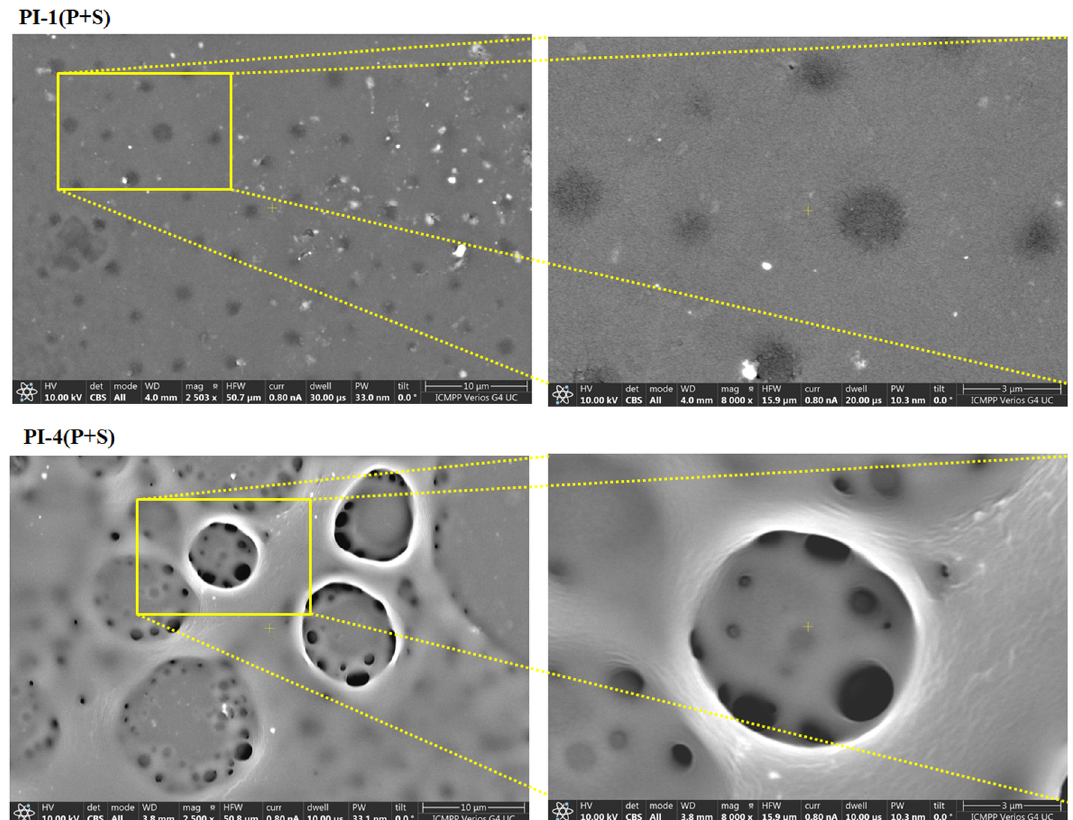
Figure 7. The SEM images of the plasma-treated and -sprayed PI-1(P+S) and PI-4(P+S) films. The AFM images and corresponding average cross-section profiles collected for the investigated PI-1 and PI-4 samples before and after DCSBD plasma treatment (P) and DCSBD plasma treatment, followed by spraying (P+S), are presented in Figures 8 and 9, respectively. The starting samples had surfaces with low values of roughness, 2–5 nm, as seen in Table 2. According to the height distribution on the Z axis placed on the right side of the AFM image, PI-1 showed relief with predominantly low formations, while the relief of PI-4 was mostly made up of globular formations densely and uniformly arranged on the entire surface. For this reason, the complexity of the surface morphology, expressed by calculating the surface area ratio parameter (Table 2), was higher for the copolymer. For the unmodified PI films, it can be noted that the root mean square roughness (Sq) was similar to other PI structures containing alicyclic units and chalcogen atoms in their backbone [41]. After the DCSBD plasma treatment, the resulting chemical species acted differently on the surface, depending on the imide polymer structure. An obvious roughening was observed, especially for PI-1(P) (see Figure 8), in which case, Sq and Sdr increased (even at four–four and a half time) compared to the Sq and Sdr of the control sample. For PI-4(P), the section analysis indicates an increase in size and a diminution in the density of the globular formations, leading to higher roughness, but a lower surface microtexture complexity. Thus, the surfaces of the PI-1(P) and PI-4(P) samples were activated in a different manner. The discussed values for Sq, Sdr, and Sbi surface texture parameters for the pristine- and plasma- irradiated PI films were comparable with the values obtained for other PI structures with chalcogen atoms with/without alicyclic units [42,43]. The general tendency was that the surfaces of the pristine PI films were flat and uniform with a roughness not exceeding 5 nm. Hence, the developed area depicted by the Sdr parameter and the bearing characteristics of the Sbi parameter had small values. Upon the plasma treatments of other PI structures, an increase of these parameters was noted similar to the PIs here under analysis [43]. This was attributed to the fact that plasma etching contributed to a higher developed relief, which